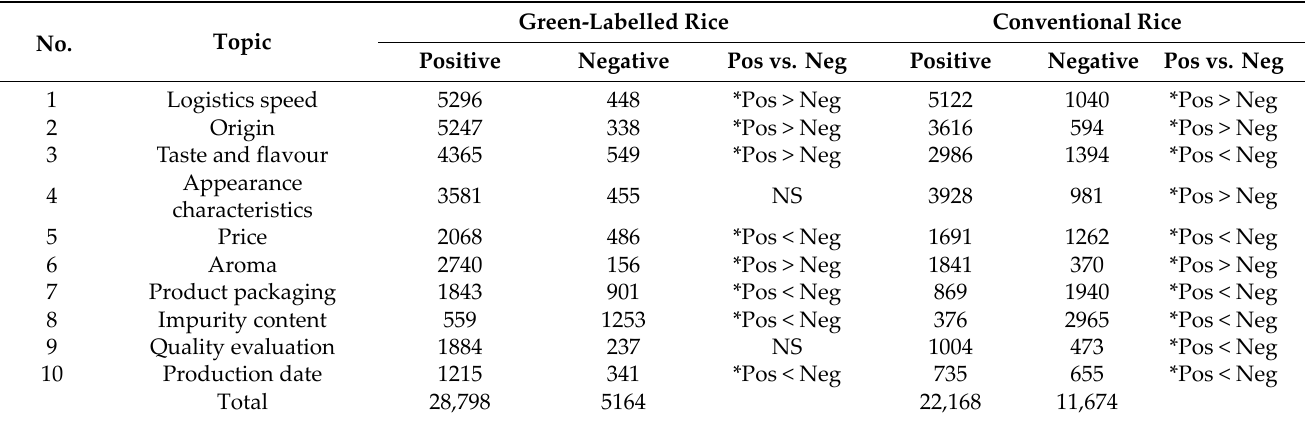
Table 5. Distribution of the number of positive and negative comments for green‑labelled rice and conventional rice and comparison of positive (Pos) and negative (Neg)